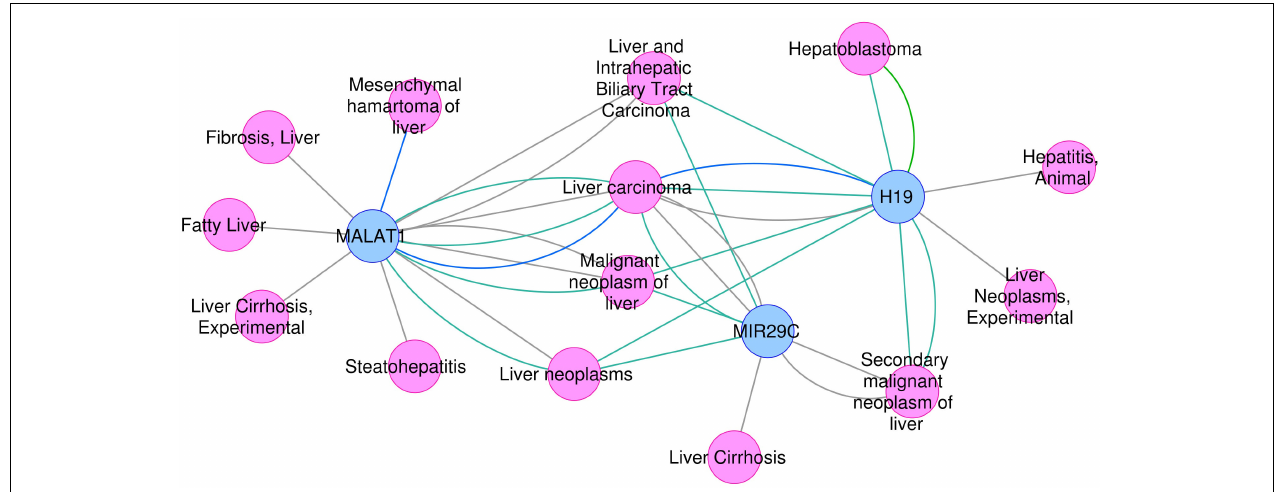
FIGURE 3 | Association between H19 , MALAT1 , and MIR29C and liver -related disease phenotypes.